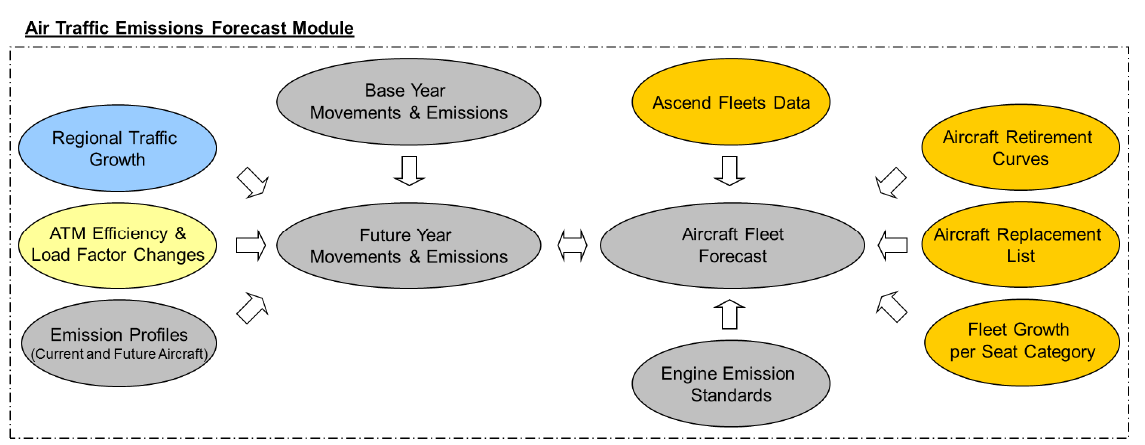
Figure 3. Schematic of the Air Traffic Forecast Module Source: Schaefer (2012).